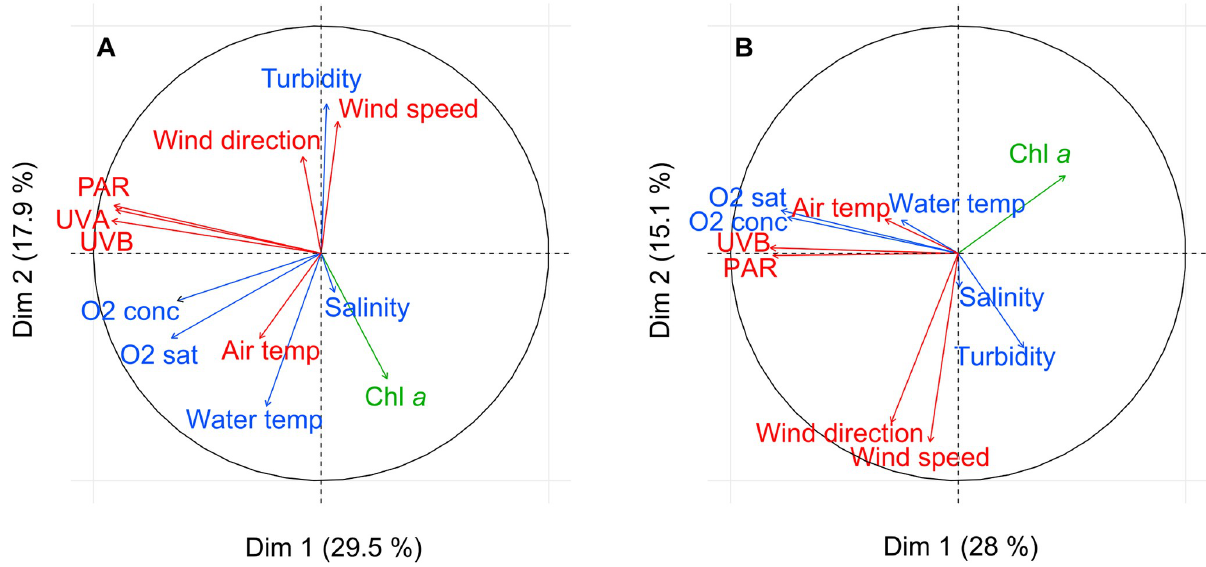
Fig 4. Principal component analysis (PCA) of environmental variables. PCA of Chl a , meteorological and hydrological data for the 2015 data set (A) and 2016 data set (B). PCA allows the variables to be projected in multidimensional space to highlight the relationships between them. Here, only two dimensions are represented as they explain the environmental dynamic well. The arrows represent the variables. When arrows are far from the center and close to each other, they are positively correlated, whereas when they are symmetrically opposed, they are negatively correlated. If the arrows are orthogonal, they are not correlated. Finally, when the variables are close to the center, they are not well projected in the dimensions represented; consequently, it is hard to conclude that a relationship occurs between these variables. In this last case, to highlight masked links, we coupled the PCA with pairwise Spearman’s rank correlations as described in the Material and